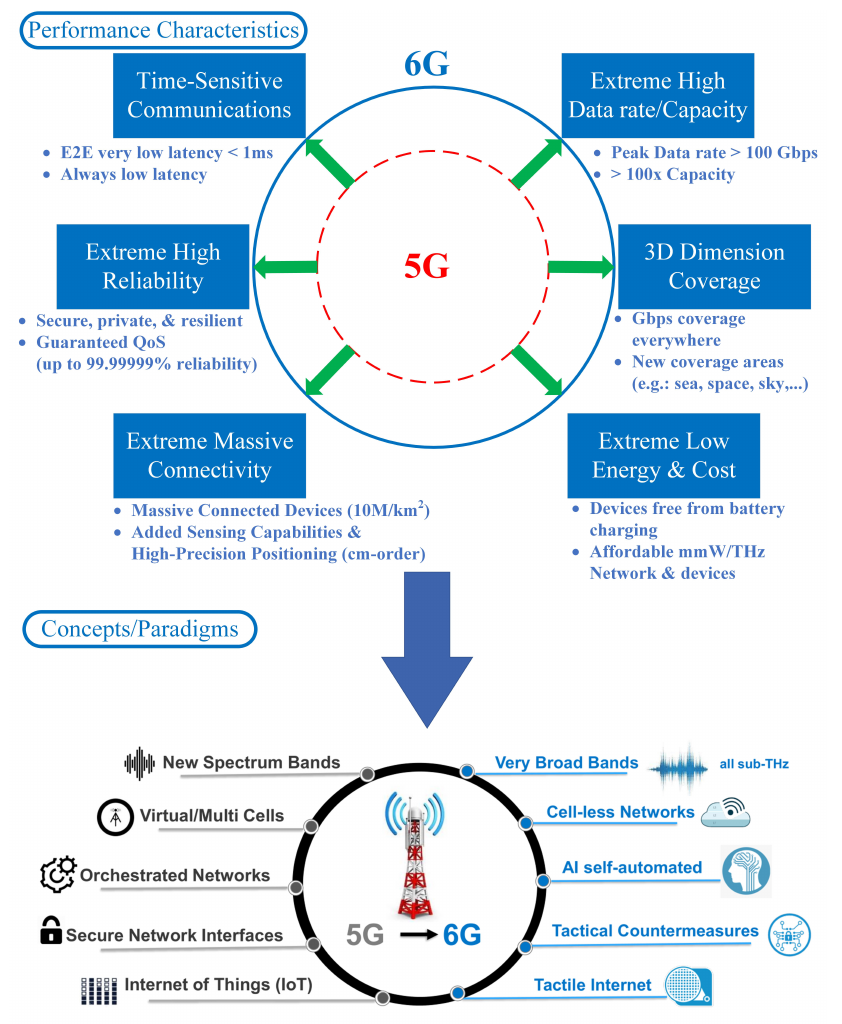
Figure 2. The 6G evolution requirements compared to 5G in terms of KPIs and